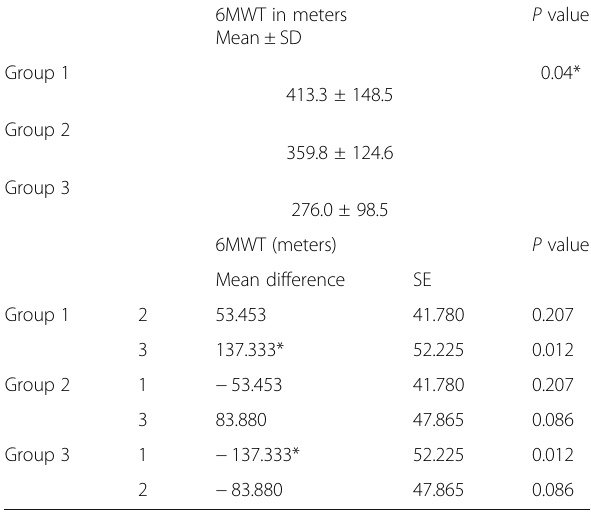
Table 5 Clinical functional capacity assessment through